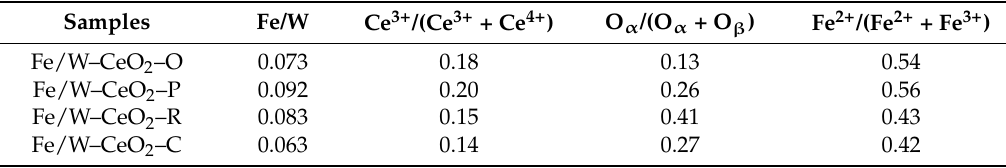
Figure 5. XPS spectra of ( a ) Fe 2p, ( b ) Ce 3d, ( c ) W 4f, and ( d ) O 1s for Fe/W–CeO 2 catalysts. Table 2. Surface atomic concentration.